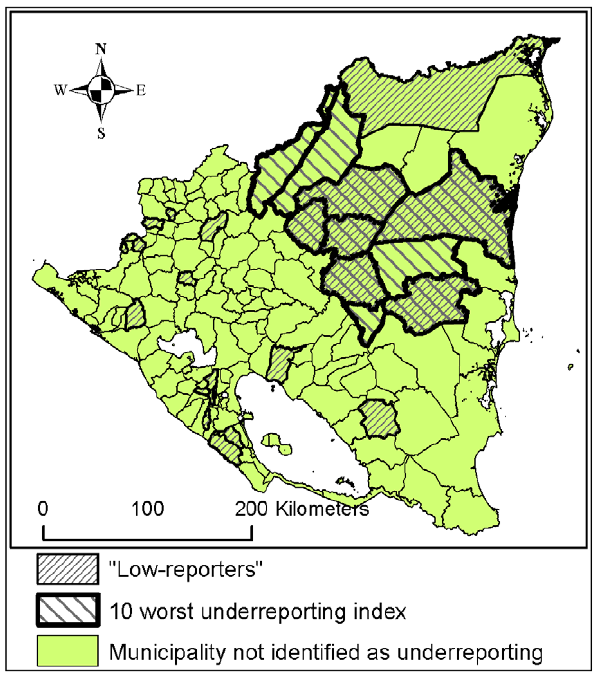
Figure 6. Spatial distribution of municipalities suspected to be underreporting. The 10 municipalities with the worst underreporting indexes and the 24 municipalities identified as ‘‘low-reporters’’ (see Methods section: ‘‘Identification of